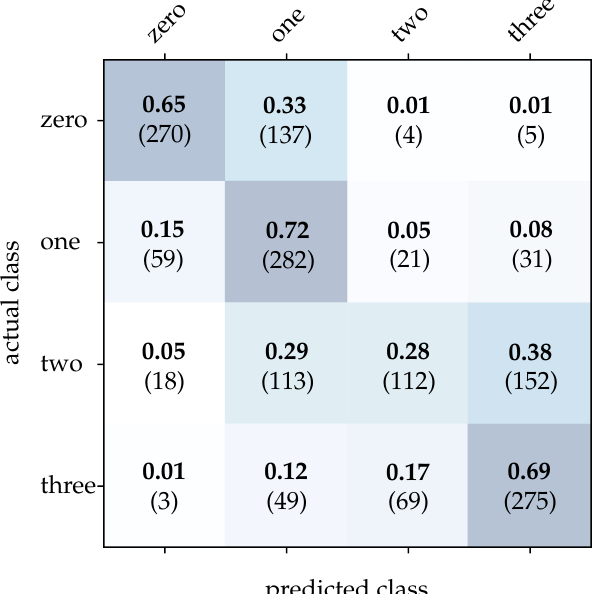
Figure 13. Classification results using MatrixLSTM and the wooden balls dataset. The bold values denote the relative frequency, the number in brackets the absolute number of samples.